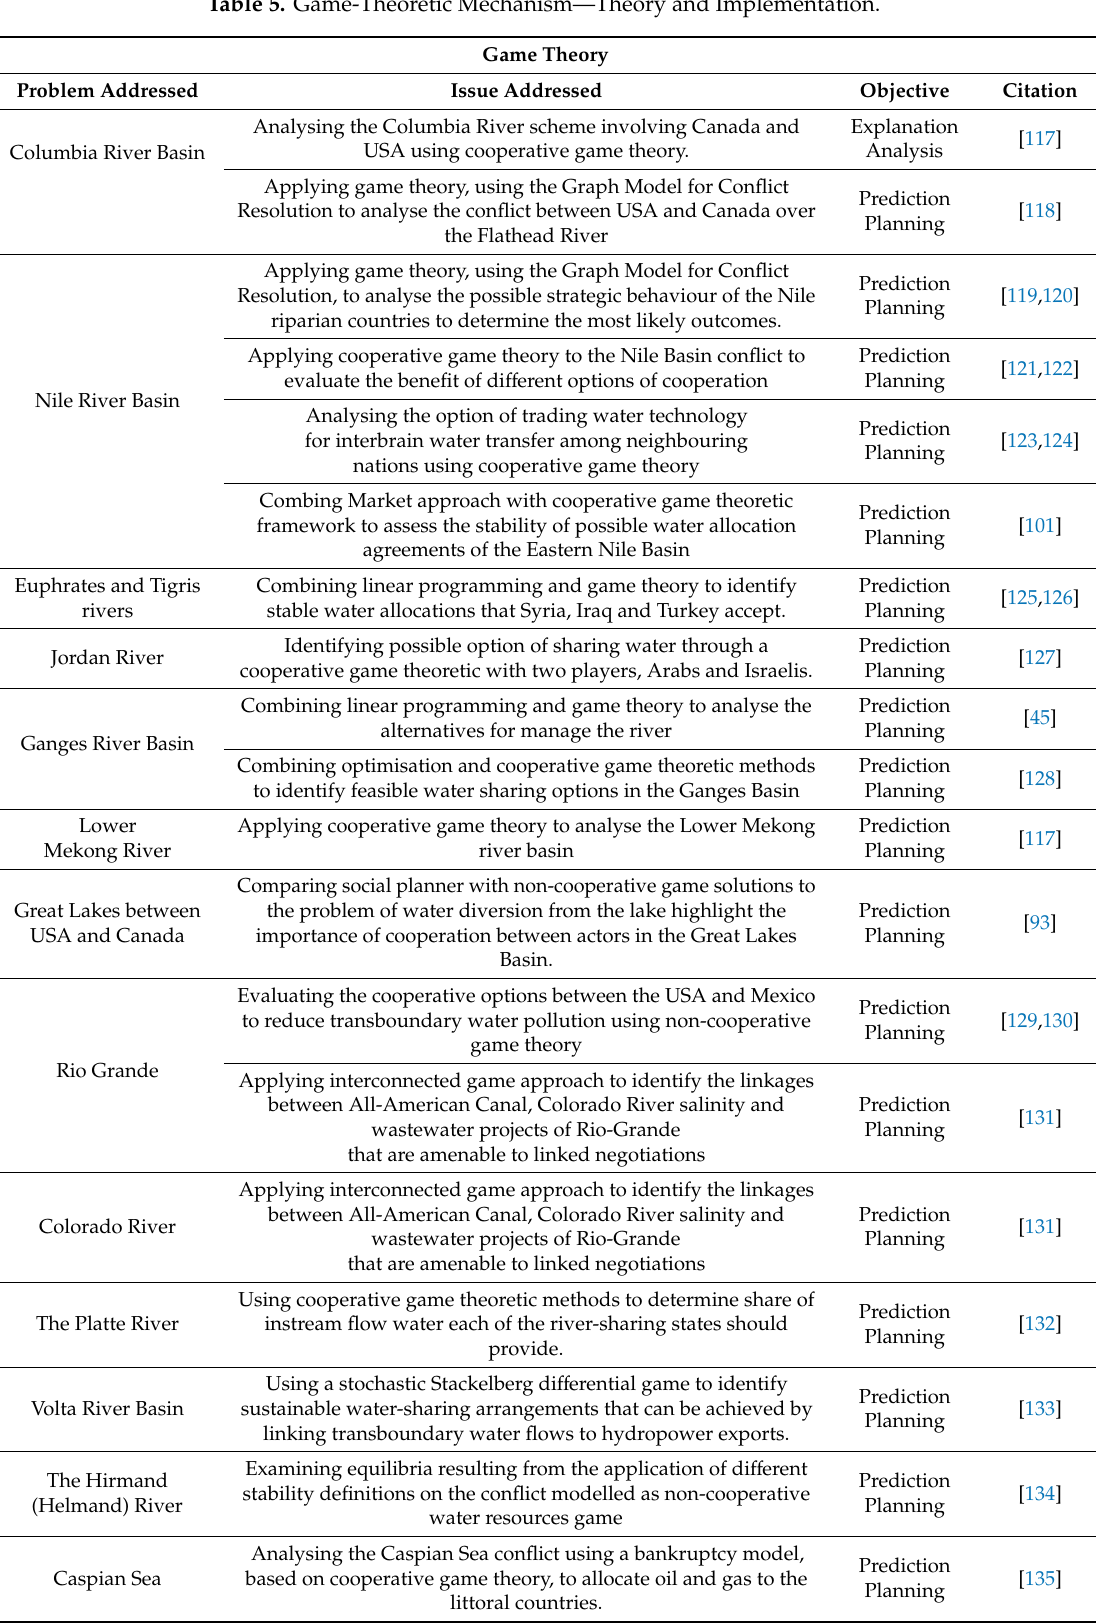
Table 5. Game-Theoretic Mechanism—Theory and